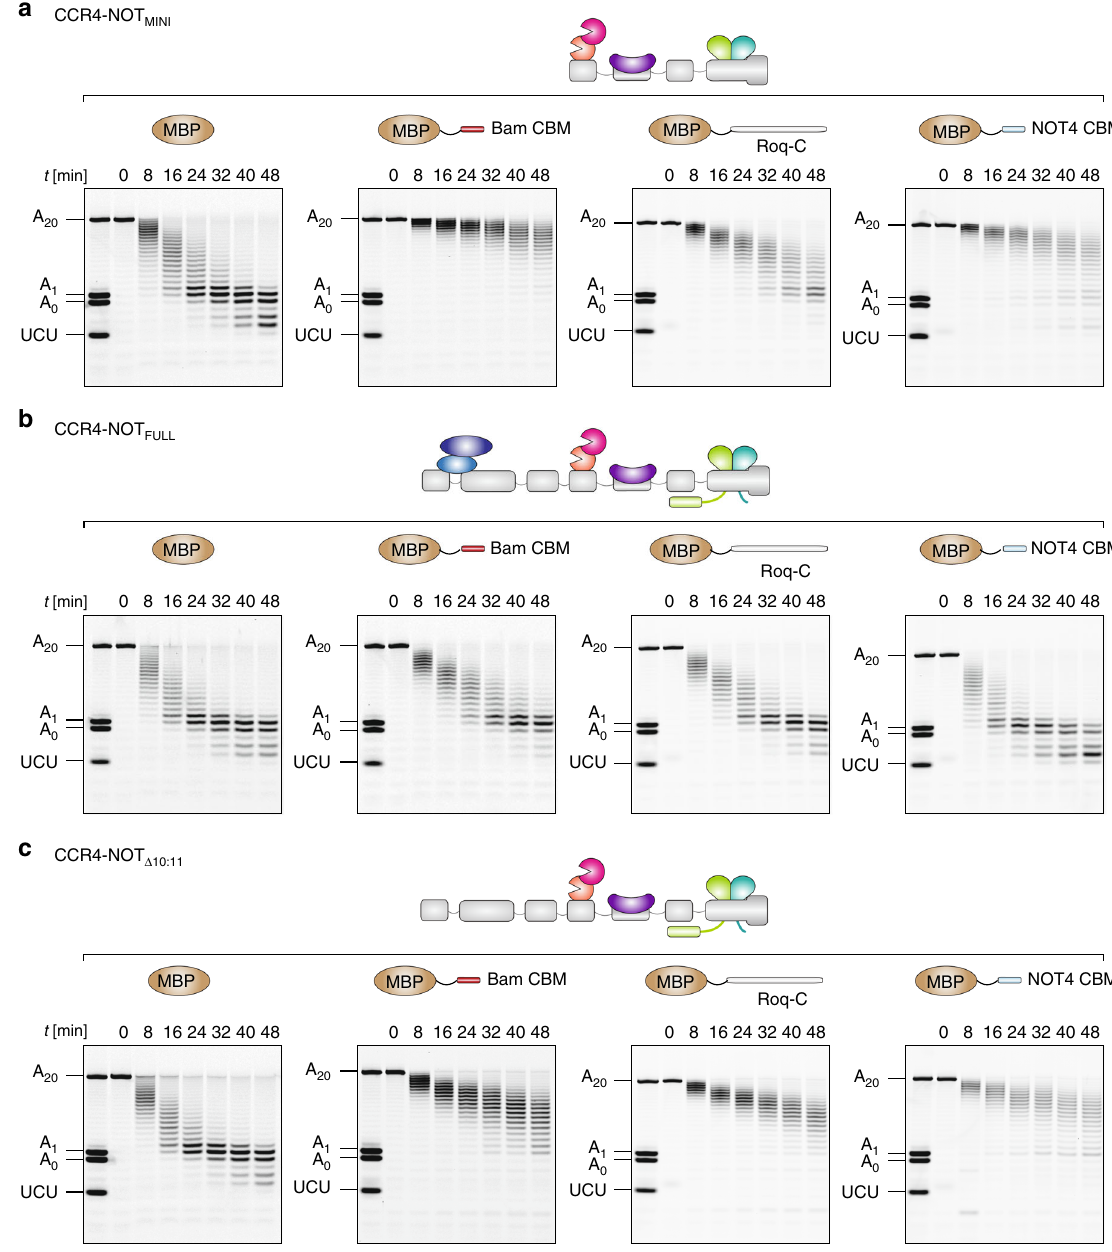
Fig. 5 Motifs from multiple CCR4-NOT recruitment factors inhibit deadenylation. a – c Deadenylation assays with equimolar concentrations (50 nM) of the 7-mer-A 20 substrate and the CCR4-NOT MINI ( a ), CCR4-NOT FULL ( b ), or CCR4-NOT Δ 10:11 ( c ) complexes, respectively. 2.5 µ M of either MBP (as a negative control) or MBP-tagged Bam CBM WT , Roquin-C or NOT4 CBM, respectively, were tested with the reconstituted complexes. All three motifs inhibited the deadenylation reaction of all three complexes but the extent of the inhibition was variable. The CCR4-NOT complexes lacking the NOT10: NOT11 heterodimer were strikingly more sensitive to the inhibition by the peptide motifs. Source data are provided as a Source Data fi (PABPC1) 7,35 . Our results indicate that the functional dis- tinction between CCR4a and CAF1 exists also in the absence of PABPC1.